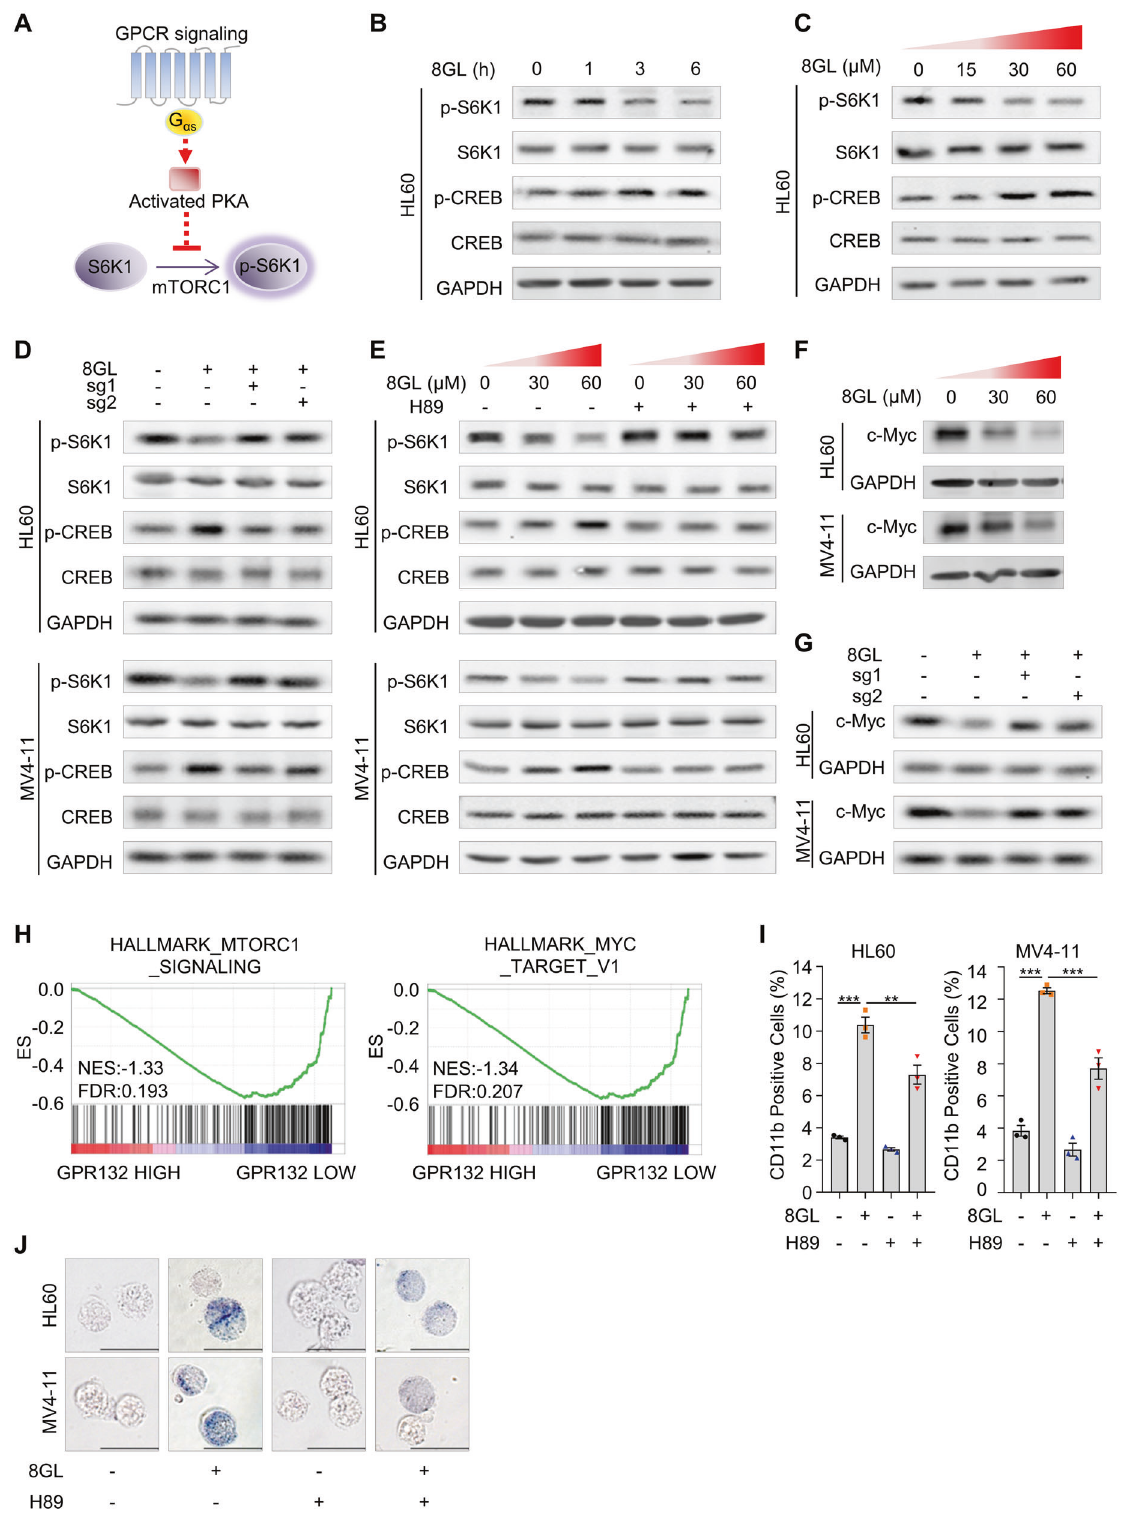
blockade and clonal expansion of leukemic cells [48, 49]. Recently, the Guan group [50] reported that the G α s -cAMP-PKA axis is involved in the negative regulation of mTOR signaling in non- cancerous HEK293A cells (Fig. 5A). We thus hypothesized that GPR132 activation by 8GL may downregulate mTOR activity